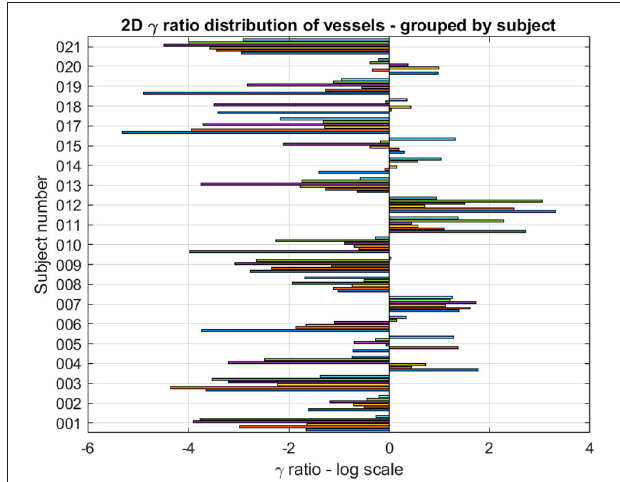
FIGURE 10 | For each subject and lung vessel are plotted the logarithm of the ratio of relative volumes of variability determined from the 95% CL ellipsoids of variability between the eDIBH and HFPV. Negative values indicate lesser variability with eDIBH, positive values lesser variability with